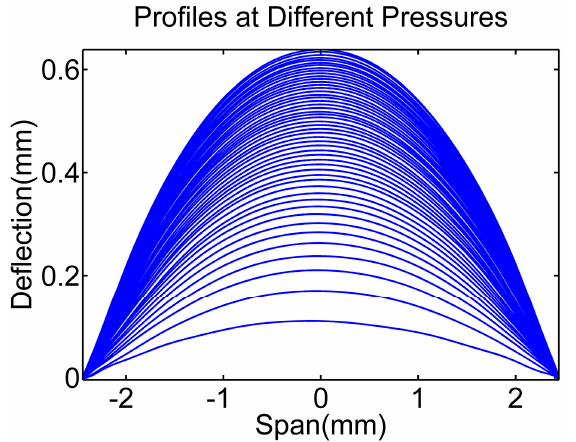
Figure 9. Profiles of deformed membrane in experiments, the exerted pressures are from 0 to 25 mbar with the step of 0.5 mbar. Micromachines 2016 , 7 , 92 11 of 13